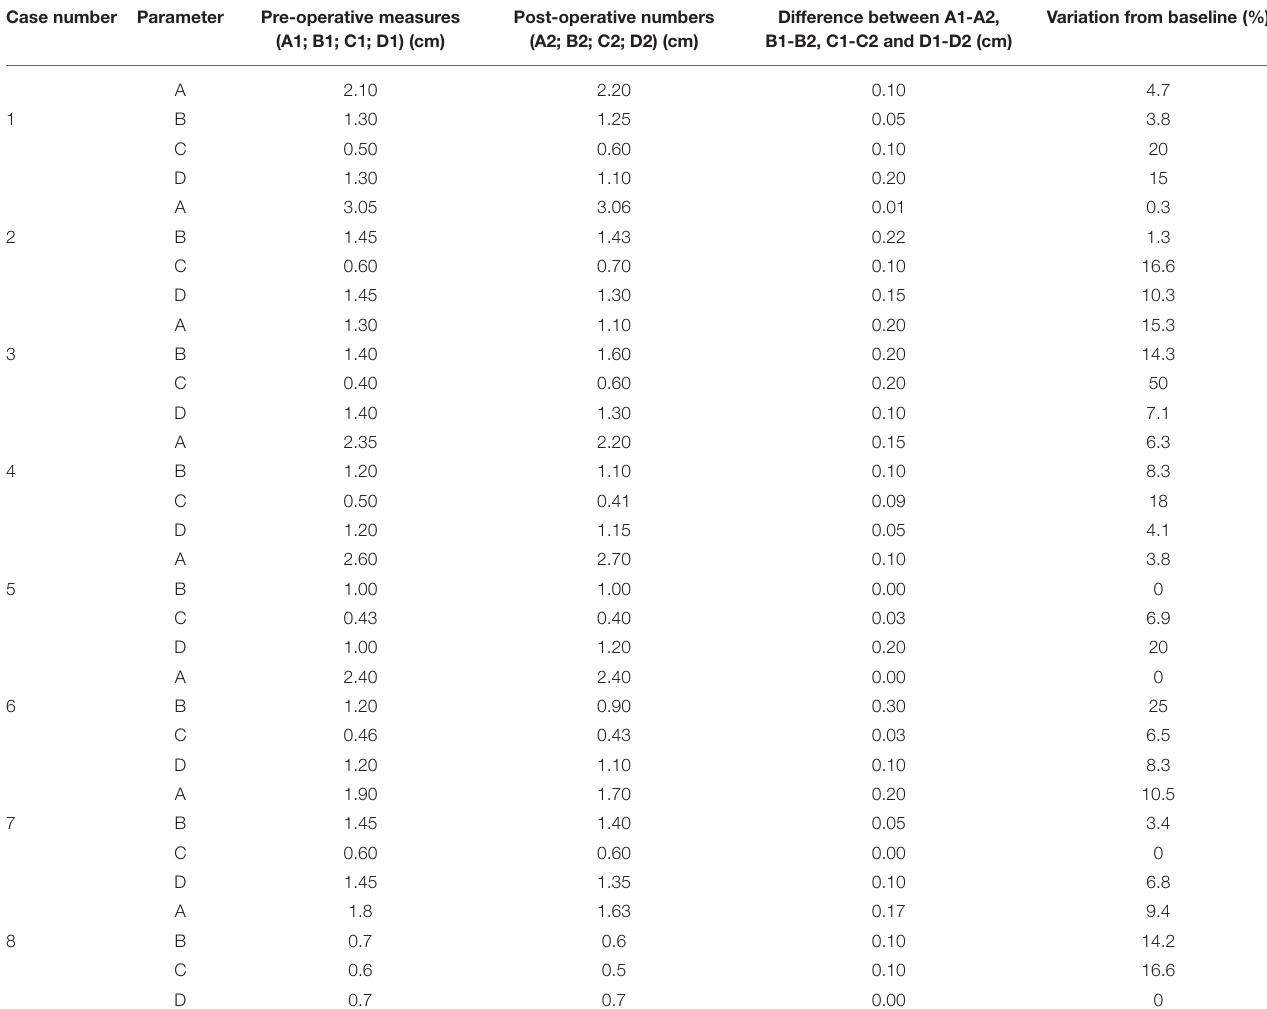
TABLE 2 | Pre- (A1, B1, C1, D1) and post-operative (A2, B2, C2, D2) measures obtained from eight cases undergoing hypophysectomy with the use of a 3-dimensional printed guide. Case number